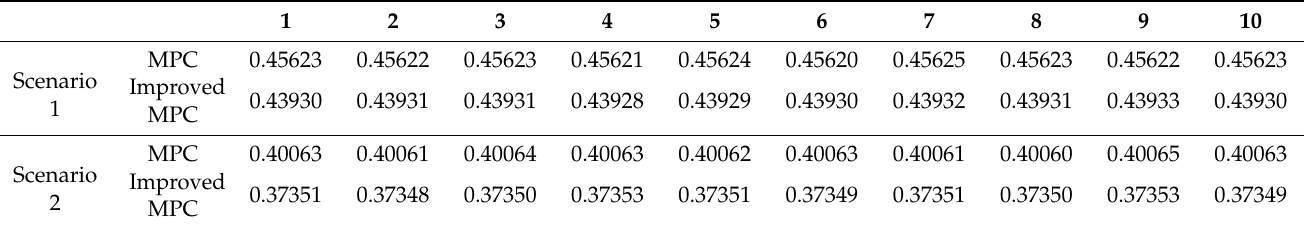
Table 6. Total fuel consumption of 10 experiments (liter).